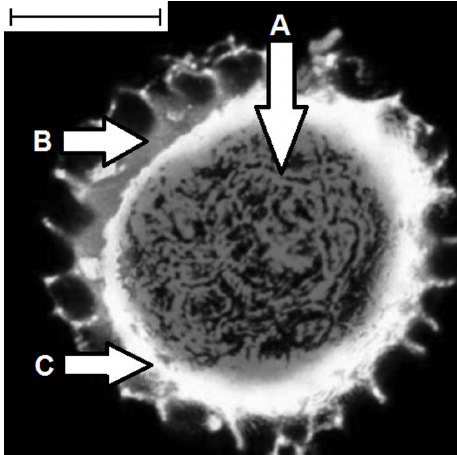
Figure 4. Confocal laser scanning microscopy image of a coencapsulated exine shell from a L. clavatum spore: ( A ) encapsulated Malachite green (the active); ( B ) exine wall; and ( C ) cocoa butter (coencapsulated). Scale bar: 60× oil immersion